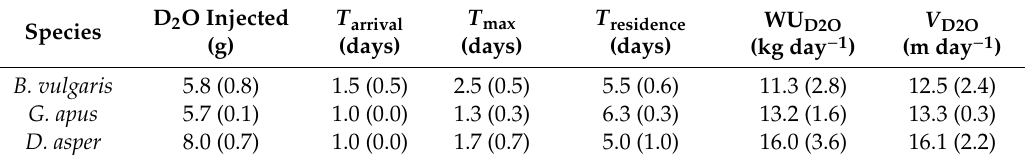
Table 2. Water transport characteristics of the bamboo species B. vulgaris , G. apus, and D. asper as based on deuterium tracing on four culms for B. vulgaris and three culms for G. apus and D. asper : amounts